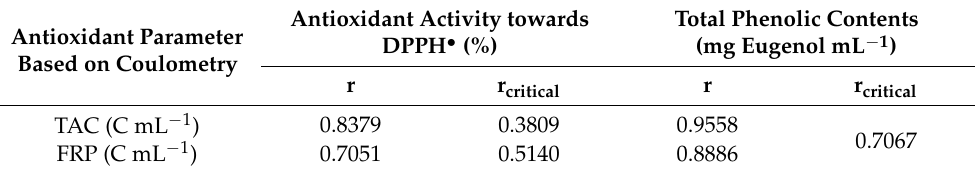
Table 5. Correlation coefficients of the antioxidant parameters of essential